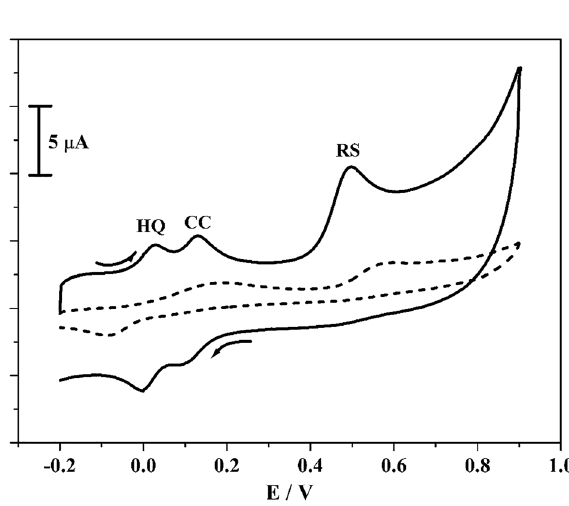
Figure 11. CVs curve for simulataneous examination of CC, RS and HQ (10 µM) in 0.2 M PBS of pH 7.4 at BCPE (scattered streak) and poly(CBBG)/MCPE (hard streak) with scan rate 0.05 Vs −1